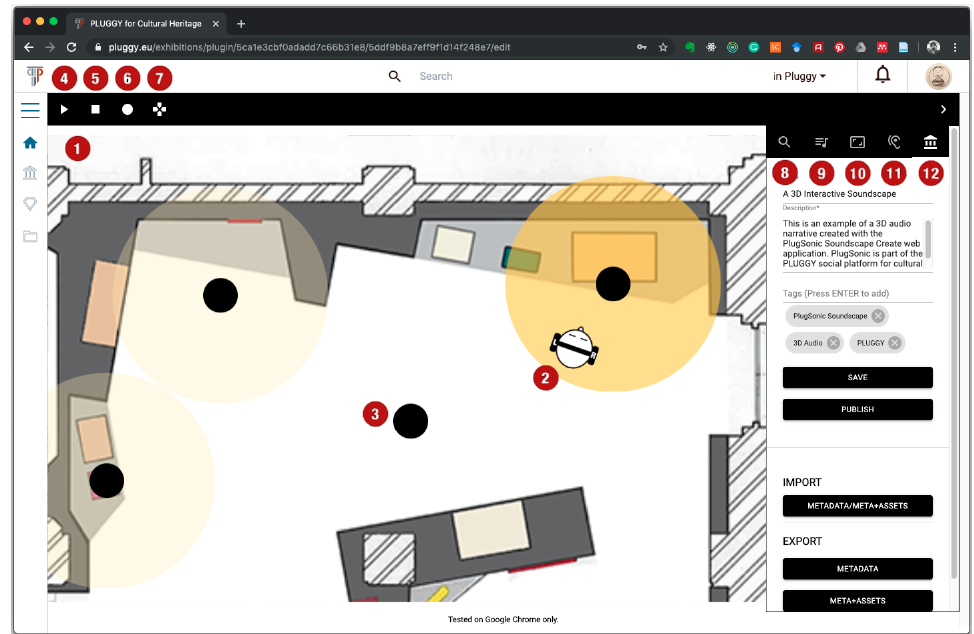
Figure A2. PlugSonic Soundscape Create user